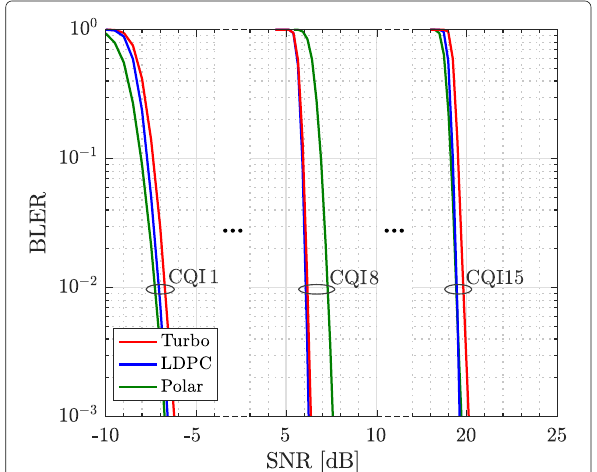
Fig. 15 SNR-to-BLER mapping example. This figure shows an example of SNR-to-BLER mapping for three CQI values that correspond to OFDM modulation with 4, 16, and 64 quadrature amplitude modulation (QAM) for three different coding schemes that use the same coding